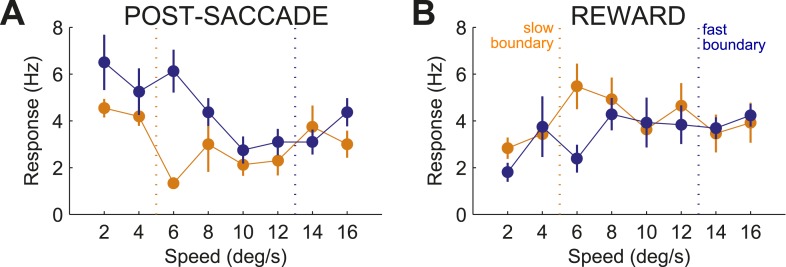
Examples of two additional caudate neurons.On average, these neurons responded differently to the same stimulus (speed 6) on trials with slow (orange) and fast (blue) boundary positions during the post-saccade (A) and reward (B) periods of the task. Same notation as in Figure 4A,B.